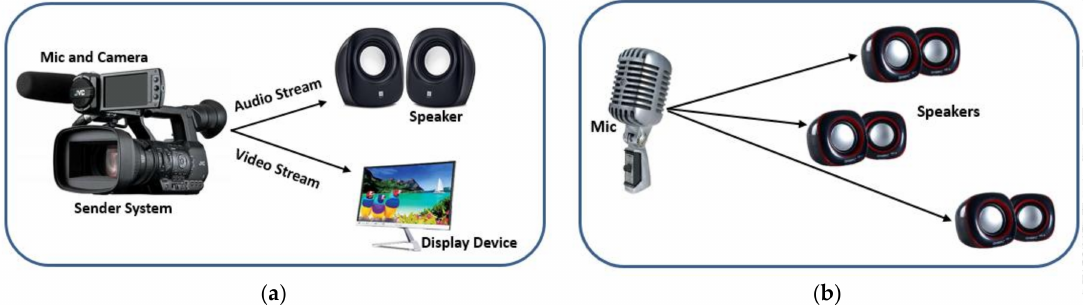
Figure 3. Problem Statement use cases: ( a ) Use case 1; ( b ) use case 2.